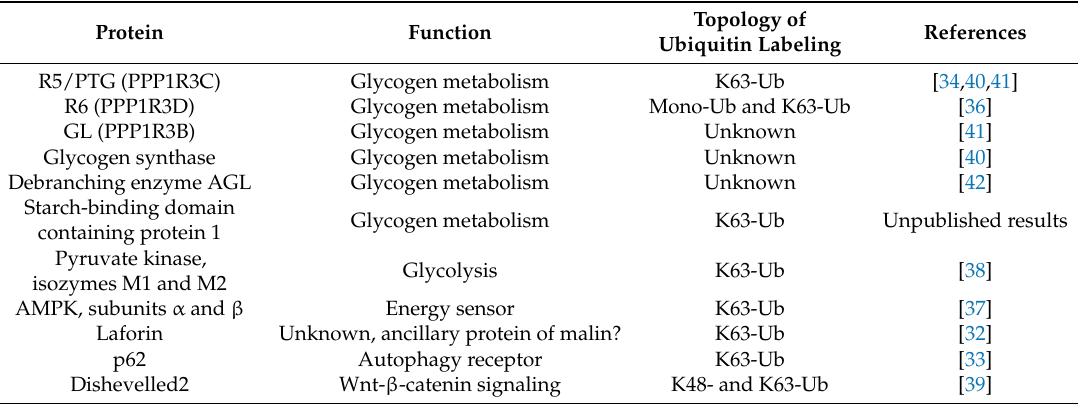
Figure 3. Schematic view of the laforin-malin complex and some of its interactors. Malin is depicted with its two domains, RING and NHLs, and interaction with one of its specific E2-conjugating enzymes, UBE2N, is also shown. X refers to putative substrates (see text for details). Table 1. Substrates of the E3-ubiquitin ligase malin.